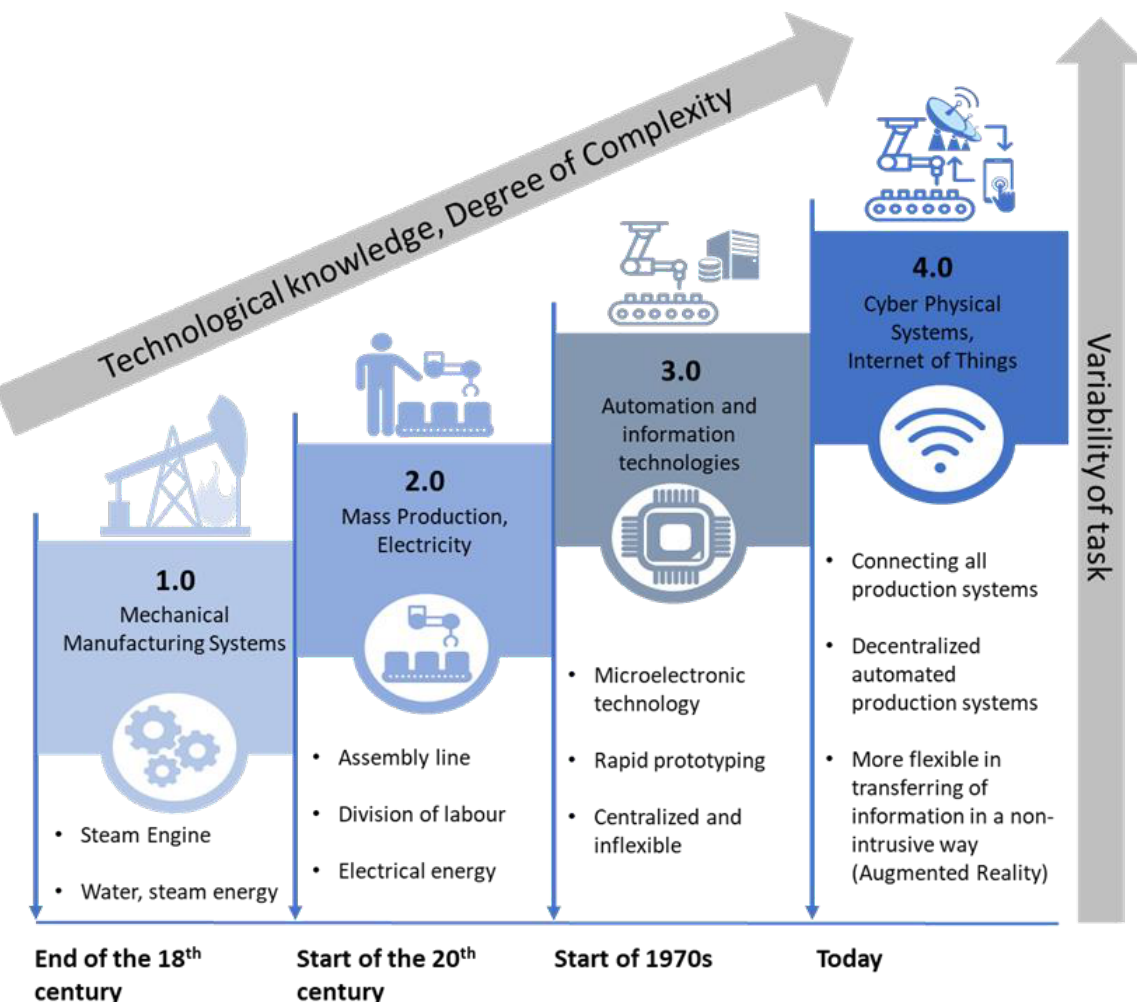
Figure 1. Industrial revolutions and their characteristics based on [1].